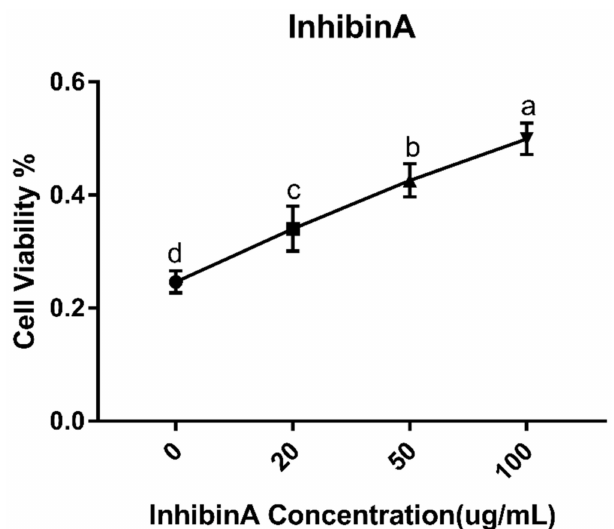
Figure 3. MTT assay of GCs cultured under di ff erent doses of inhibin A (20, 50, and 100 µ g / mL) and the corresponding control (0 µ g / mL). The measured cell counts for percent viability are indicated on the Y axis, and the doses of inhibin A are indicated on the X axis. Values are expressed as mean ± SEM of n = 3. The bars labeled with completely di ff erent letters indicate a significant di ff erence, p < 0.05.